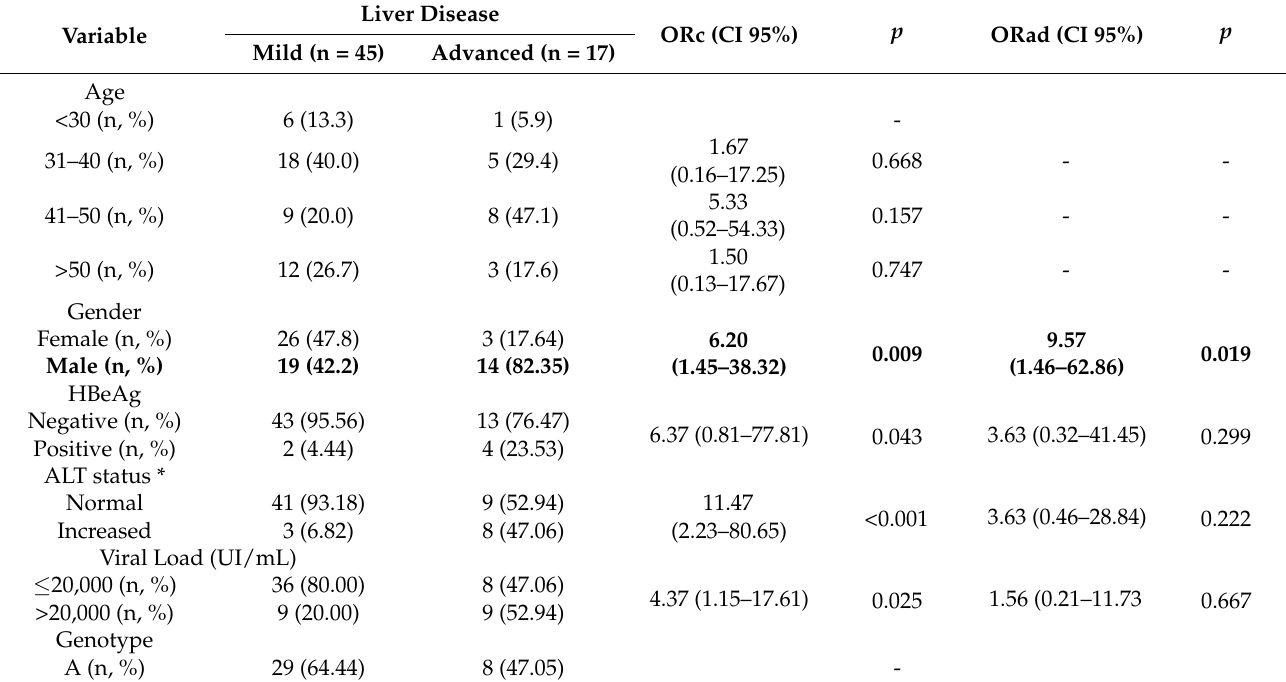
Table 3. Frequency of variables according to liver disease